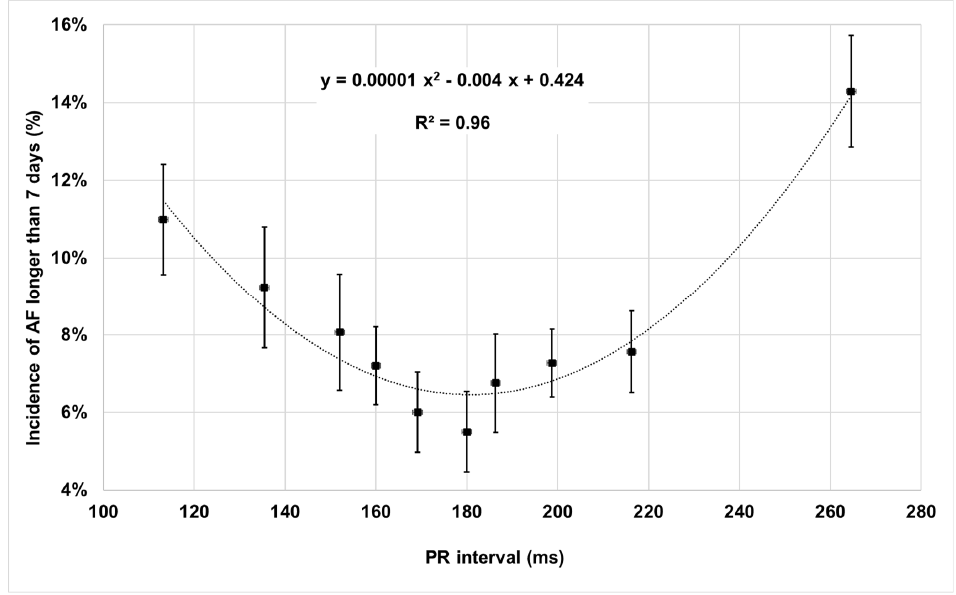
Figure 3. Incidence of atrial fibrillation longer than 7 days as a function of the PR interval.